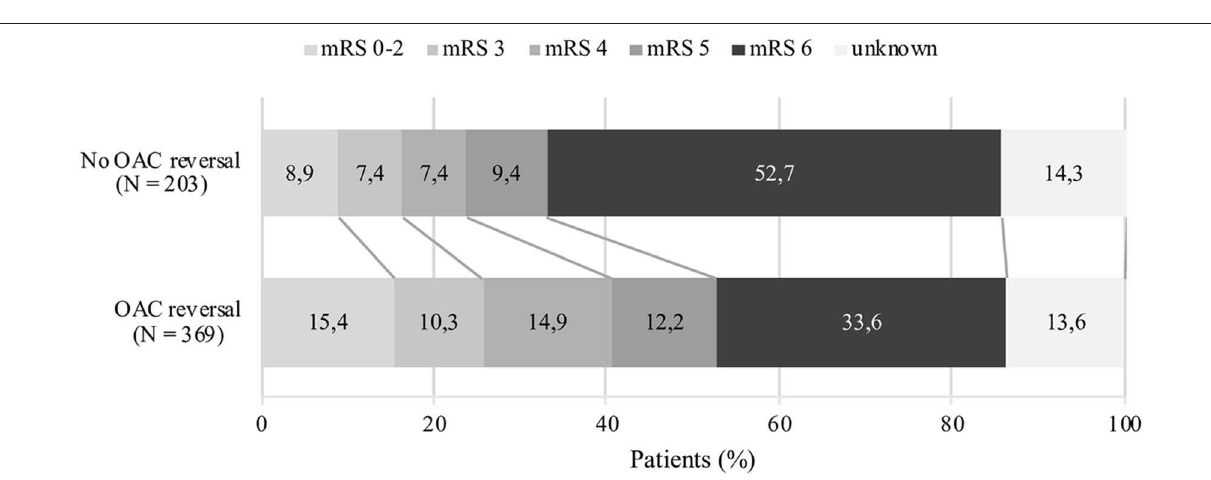
reversal treatment were more often older, comatose,